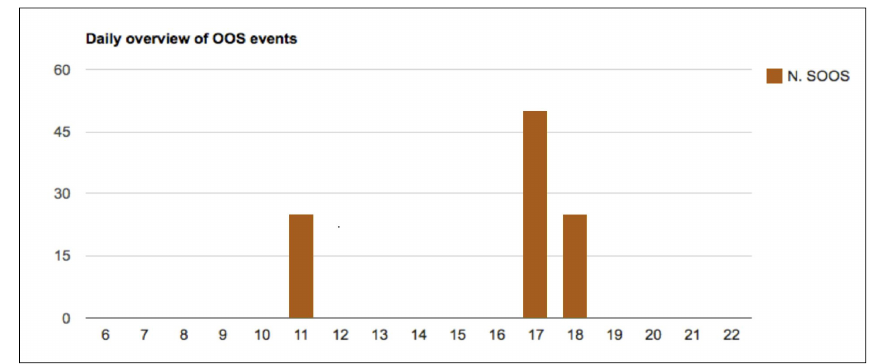
Figure 11. Rate of SOOS related to a